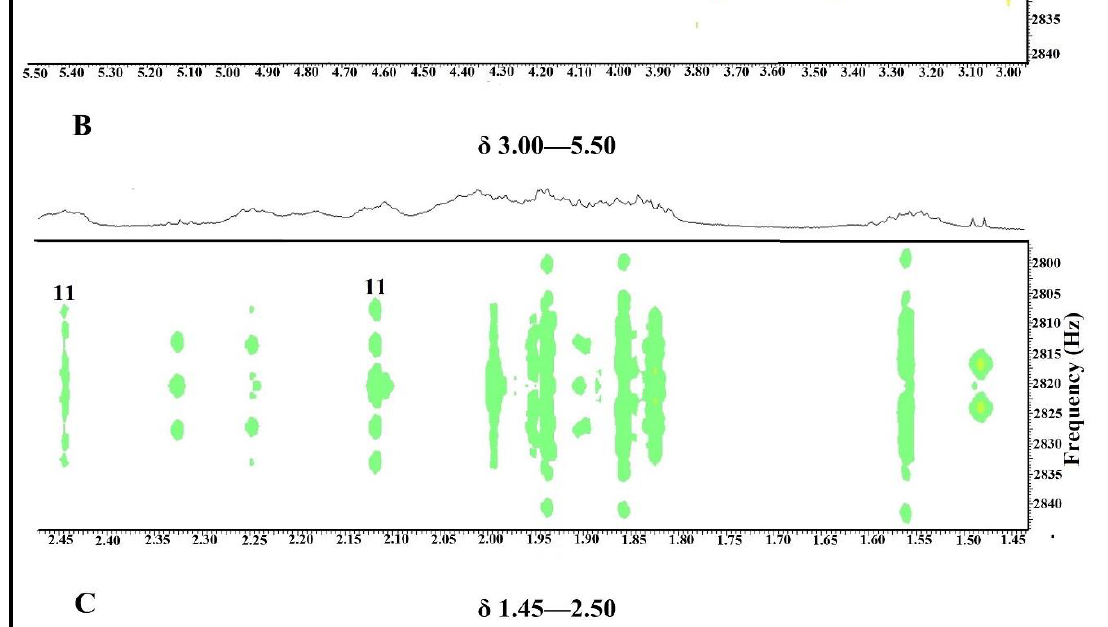
Figure 8. 500 MHz 2D J -resolved NMR spectrum of P. malayana leaves extract based on which the multiplicity and coupling constants have been analyzed. ( A ) 2D J -resolved NMR spectrum between the range of δ 5.90–7.40. ( B ) 2D J -resolved NMR spectra between the range of δ 3.00–5.50. ( C ) 2D J -resolved NMR spectrum between the range of δ